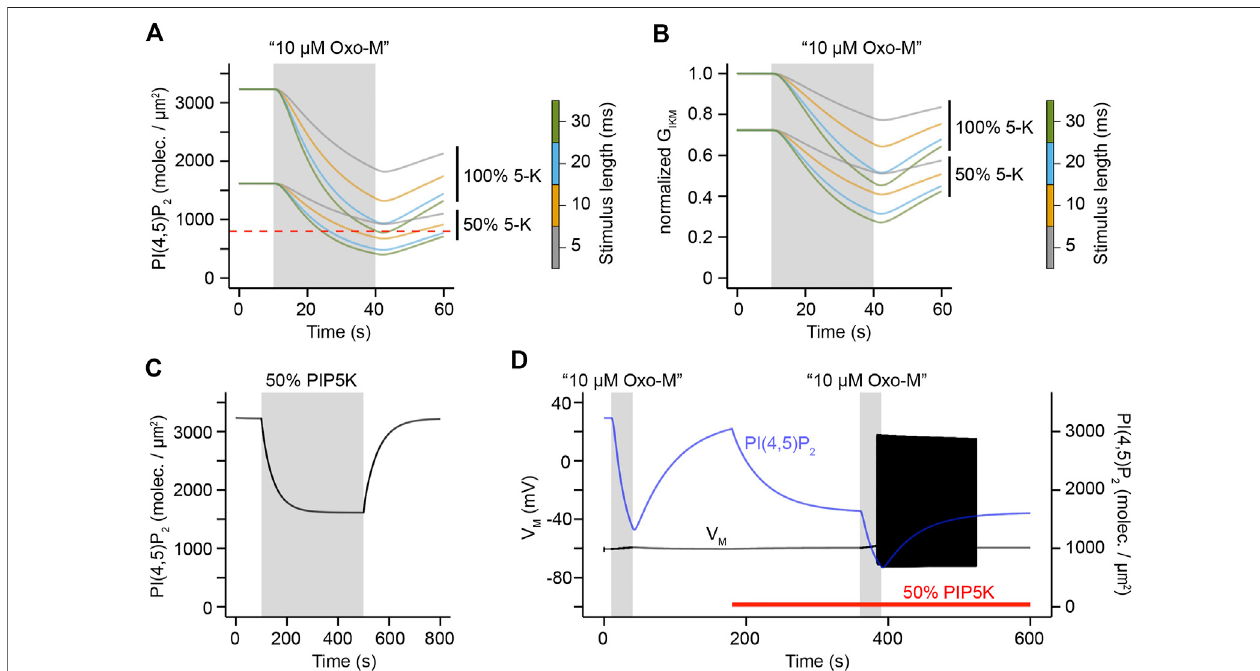
FIGURE8| RelationshipofPIP5Kactivity,PI(4,5)P 2 levels,andelectricalexcitability.A.SimulationsofPI(4,5)P 2 densitiesinresponsetoa30 sapplicationof10 μ M Oxo-M for indicated levels of PIP5K activity and stimulus durations. All stimulations were simulated for a frequency of 10 Hz. (B) . Same as (A) , but for KCNQ channel conductance. (C). Simulation of PI(4,5)P 2 levels under conditions of unmodi fi ed PIP5K activity (white background) or reduction of PIP5K activity by 50% (gray background). (D). Simulation ofmembranepotential andPI(4,5)P 2 density inresponse to30 sapplicationsof10 μ MOxo-Mat astimulus frequencyof10 Hzanda stimulus duration of 10 ms. Red bar indicates simulation period with a 50% reduction of PIP5K